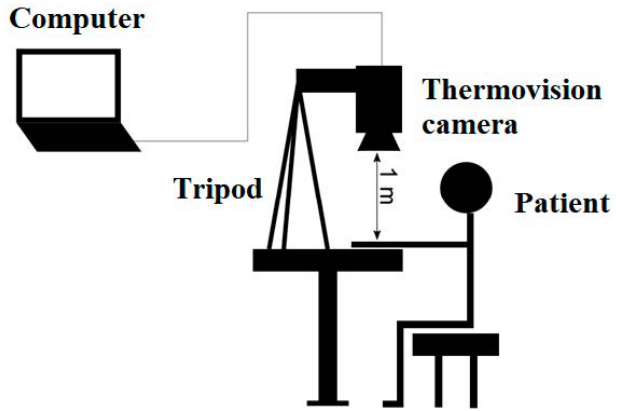
Figure 2. Set up for measurement.